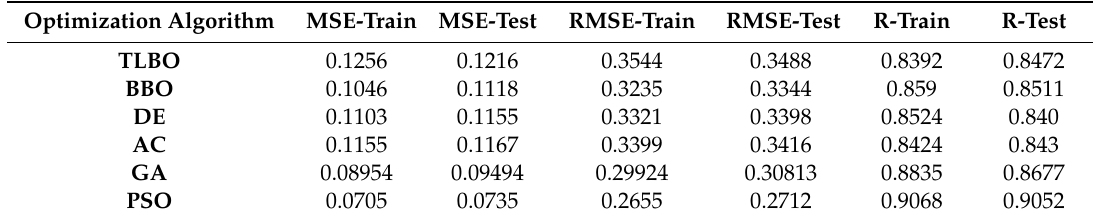
Table 3. Model evaluation criteria for six evolutionary algorithms contributing to ANFIS for refining motor load prediction.